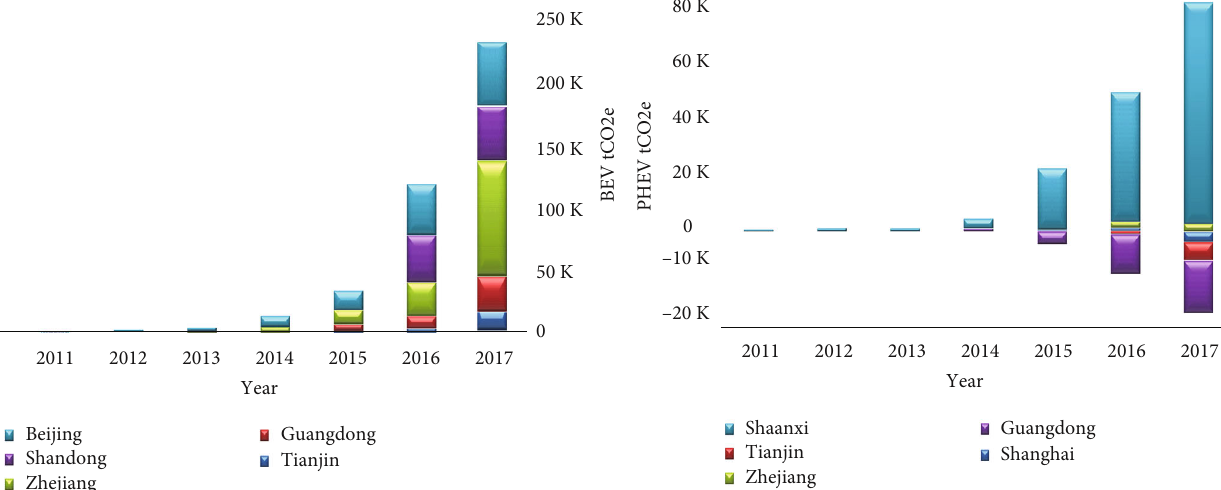
Figure 10: Top 5 BEV and PHEV CO